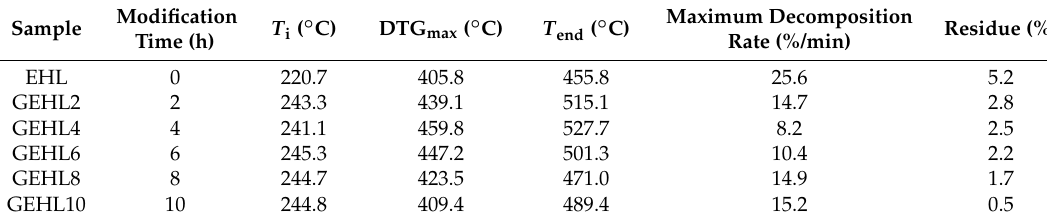
Figure 5. ( a ) TG and ( b ) DTG curves of EHL and GEHL . Table 4. Results from thermal analysis for T i , DTG max , T end , and residue